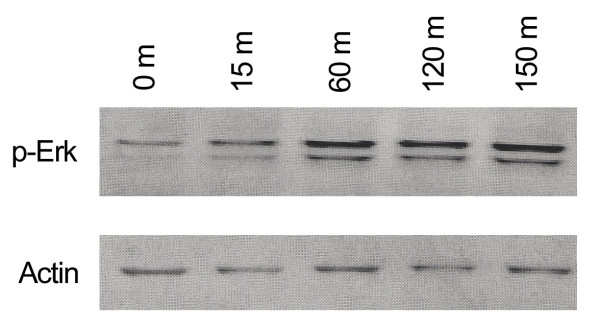
Levels of ERK activation in MDA-MB-453 cells as assessed by western blot analysis. Activation was determined after indicated times after exposure to 100 pM NNK using a phospho-specific antibody.